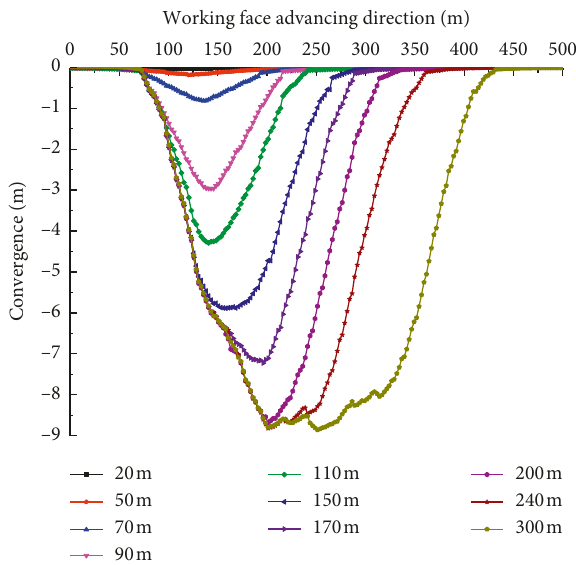
Figure 5: Subsidence curves of the main key